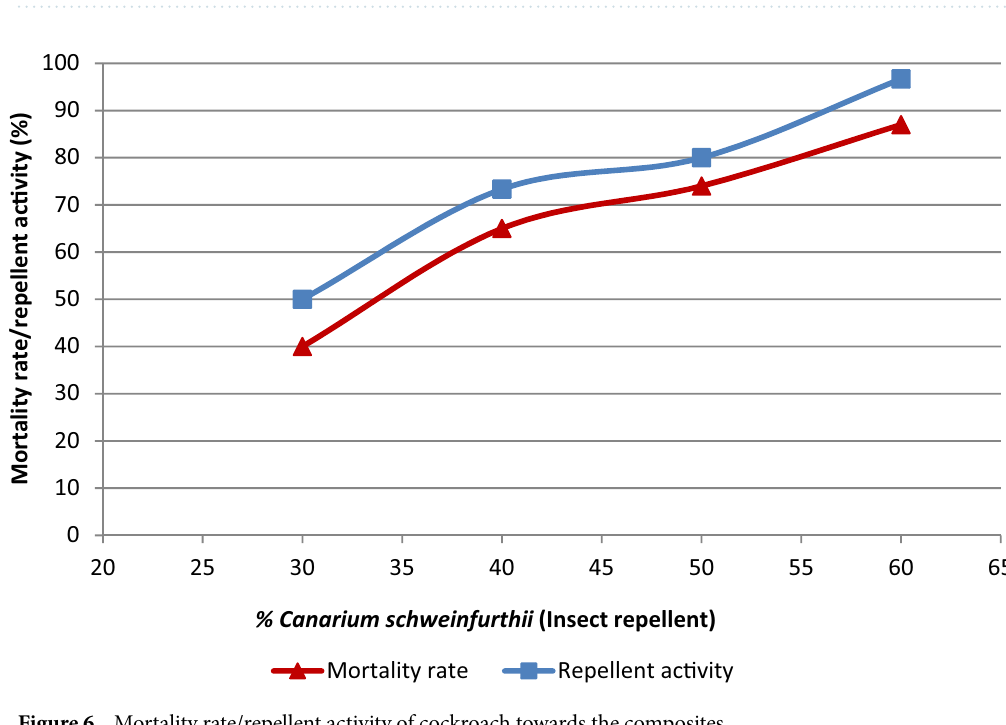
Figure 6. Mortality rate/repellent activity of cockroach towards the